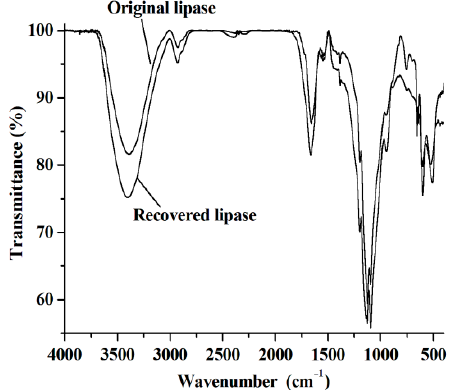
Figure 6. The FT-IR spectra of the original lipase and the recovered one.